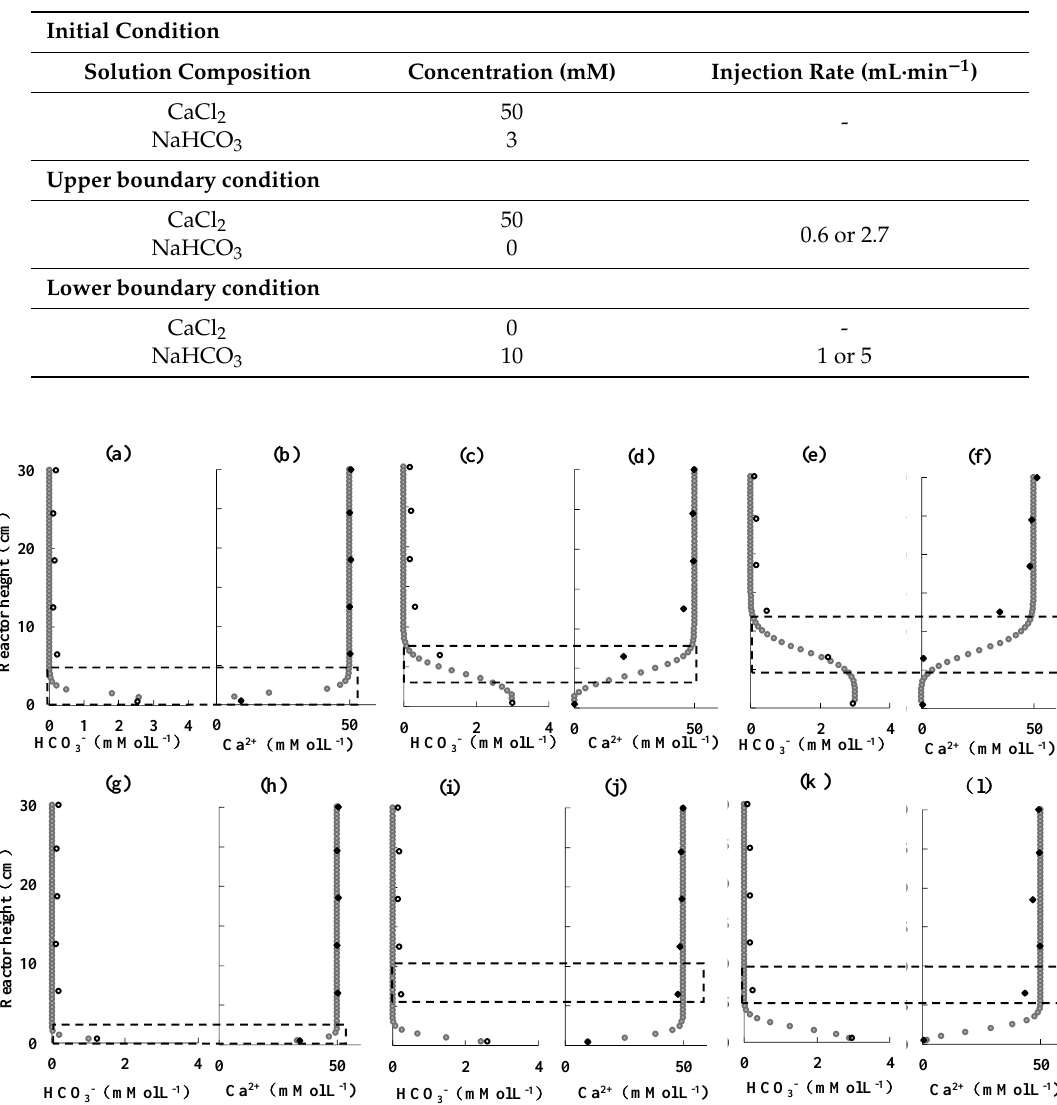
Figure 2. Fast scenario and slow scenario partly experiment and numerical simulation results. The